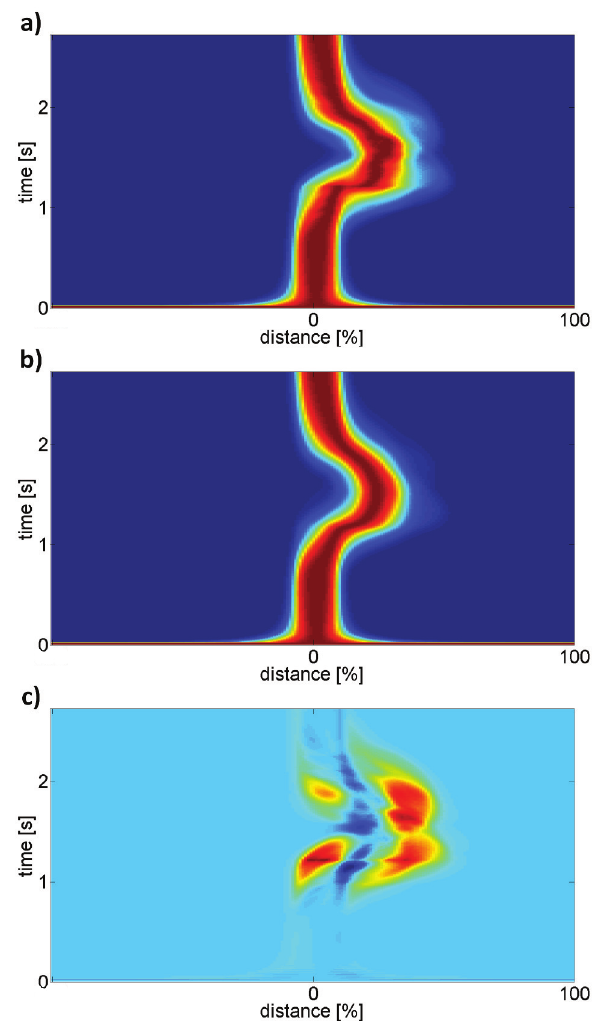
Figure 16. Comparison of a generated mean template with corresponding mathematically calculated equivalent. The chosen example is: “STEP_FORWARD”, projection distance xz between right and left foot . a) Generated template. b) Corresponding mathematical mean template. c) Difference of a) and b). Thereby, dark red represents the maximum value whereas dark blue represents the